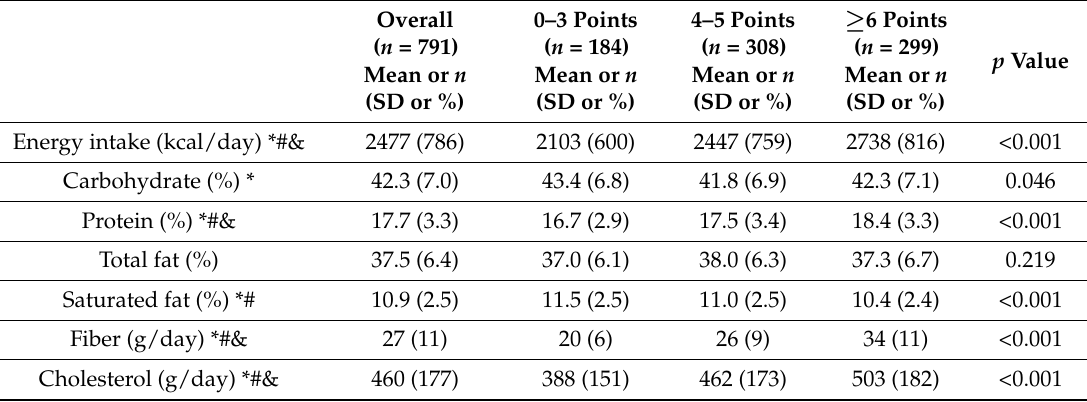
Table 4. Energy intake and daily nutrients intake by score of ATLANTIC diet and lifestyle